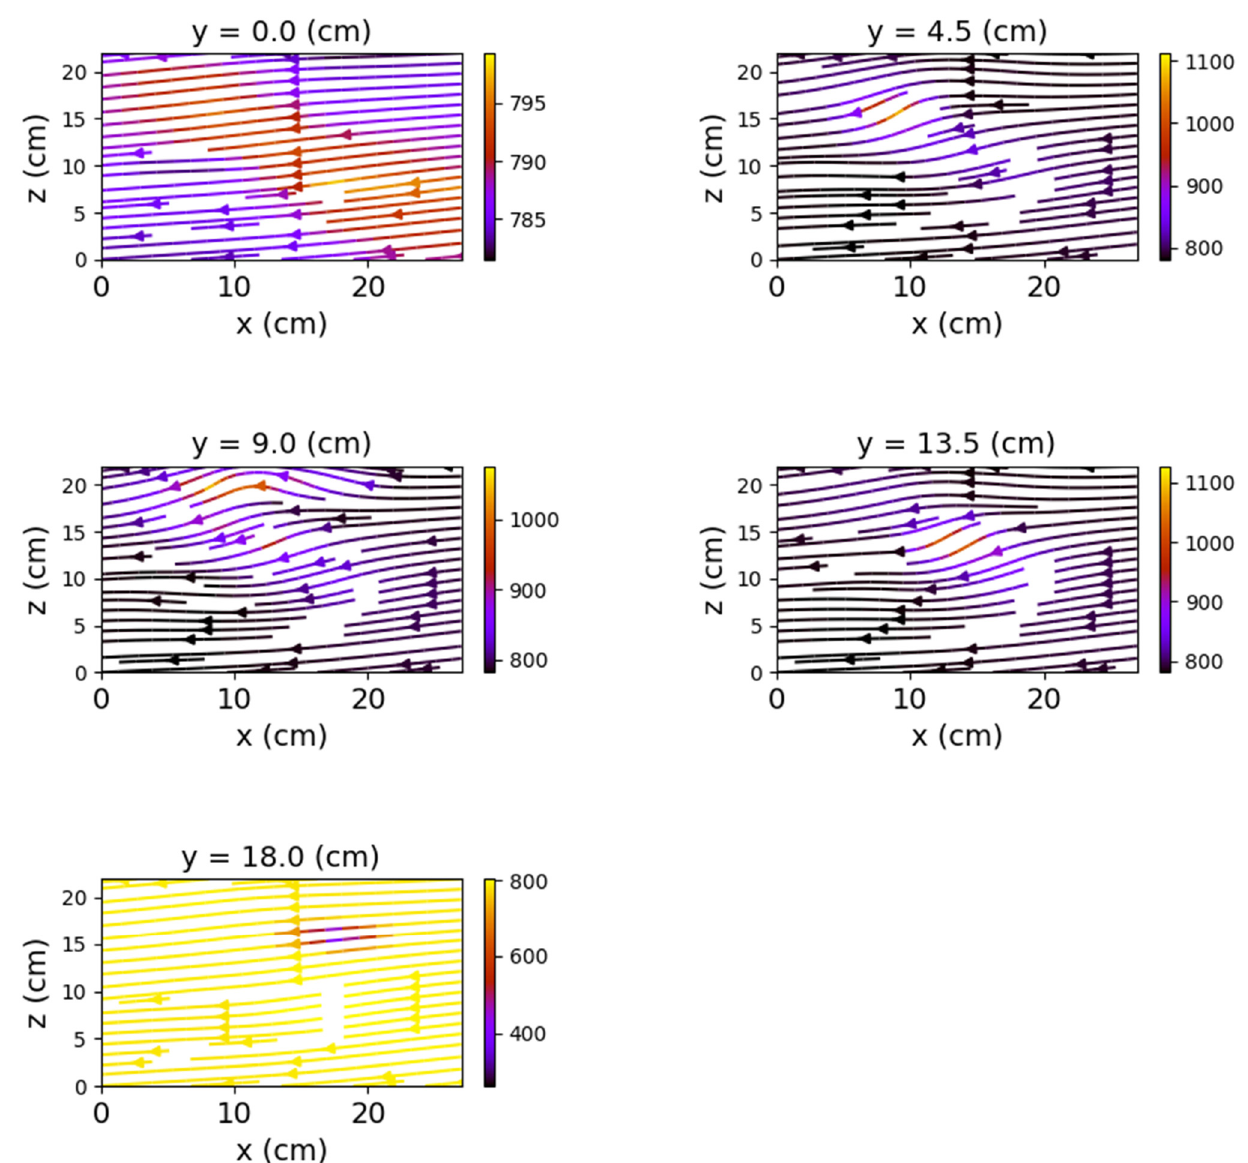
Figure 19. Field lines for x O z plane—relay with coil 2–4 powered.